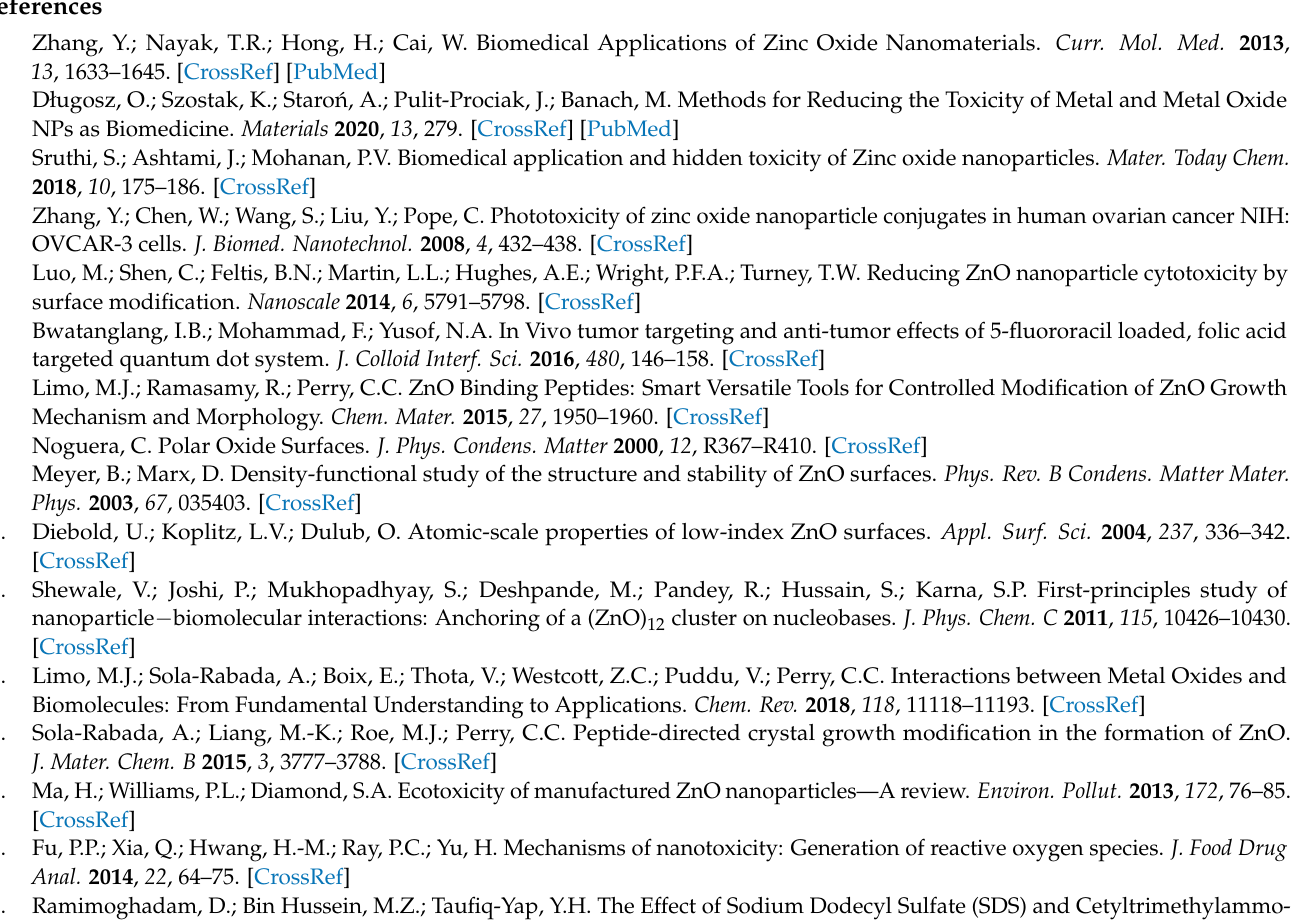
PEG sample; Figure S2: FTIR spectral analysis of pure SDS sample; Figure S3: FTIR spectral analysis of pure CTAB sample; Figure S4: UV-Vis spectral analysis of pure samples of CTAB, PEG, and